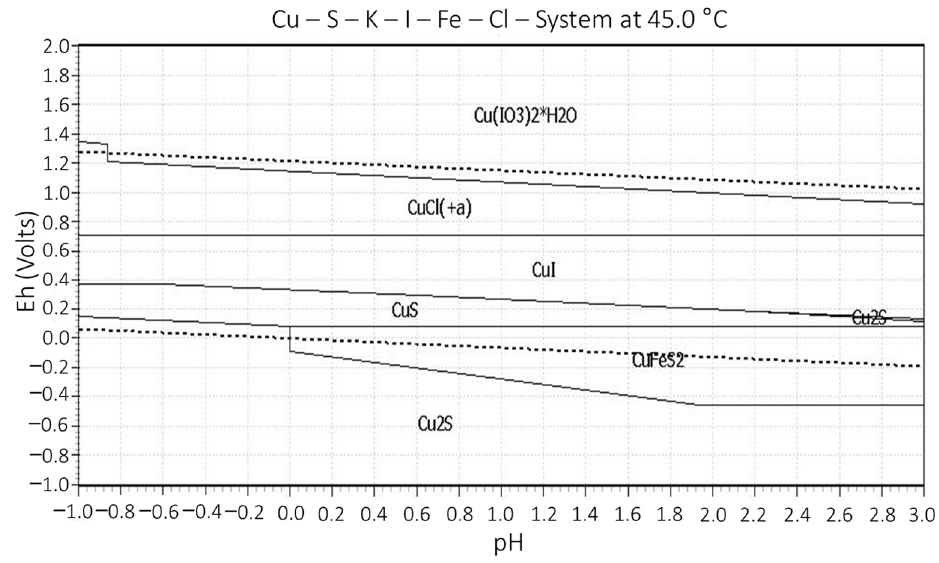
Figure 11. Eh vs pH diagram for K-I-Cu-Fe-S-Cl system at 45 ◦ C. The presence of some CuI precipitates on the surface of the chalcopyrite particles can be confirmed with SEM and EDS, as shown in Figure 12.